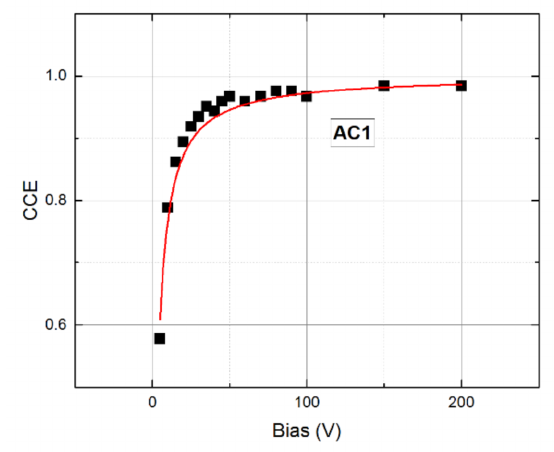
Figure 11. Hecht equation fit of the charge collection efficiency (CCE) on sample